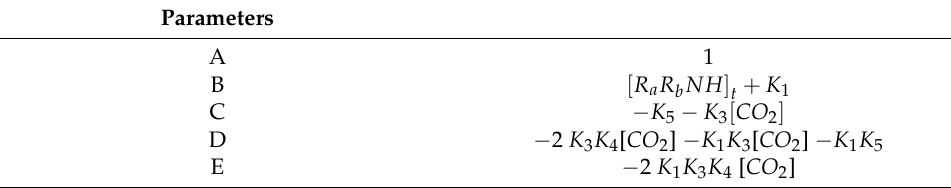
Table 5. Parameters of Equation